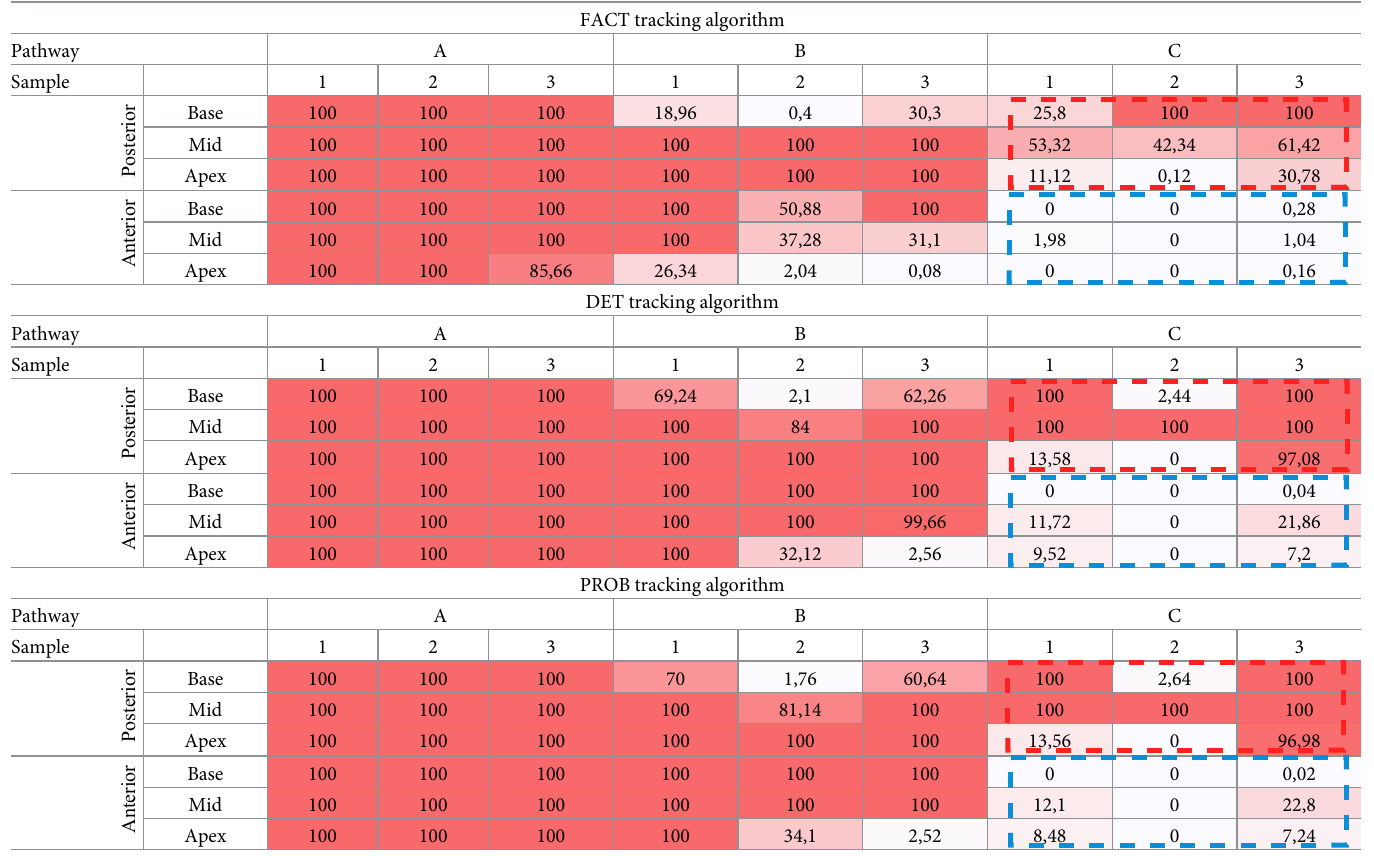
Table 1. Global myofiber architecture of the junction using seed-based tractography. Streamlines count as a percentage of the 3 samples in apex, mid-ventricular, base areas for the 3 different tracking algorithms. The ratio is defined as the number of resulting streamlines over the total number of requested streamlines. Variation in con- nectivity and variability over samples are particularly noticeable for the pathway C. Nevertheless, in all cases, the ratios were found inferior for pathway C for all areas but remained close to 100% (square with red dotted line) in the posterior junction for the base and mid-ventricular level while values were close to 0% in the anterior junction (square with blue dotted